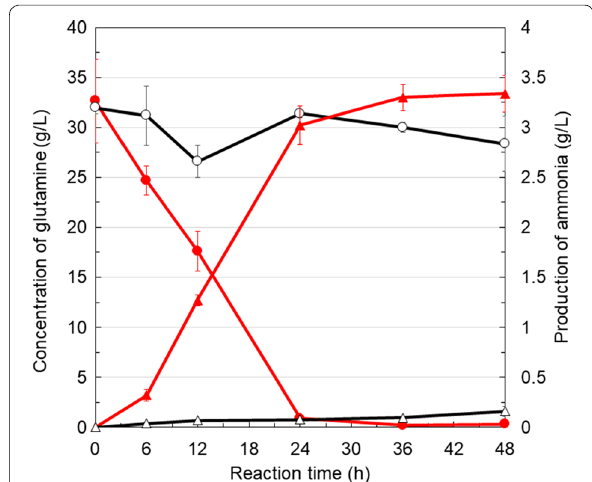
Fig. 3 Ammonia production from glutamine by YbaS-displaying yeast. The amount of ammonia produced by YbaS-displaying yeast (pULD1-YbaS, red triangle) and control yeast (pULD1-s, open black triangle), and the residual glutamine by YbaS-displaying yeast (pULD1-YbaS, red circle) and control yeast (pULD1-s, open black circle) were measured. Values are given as mean